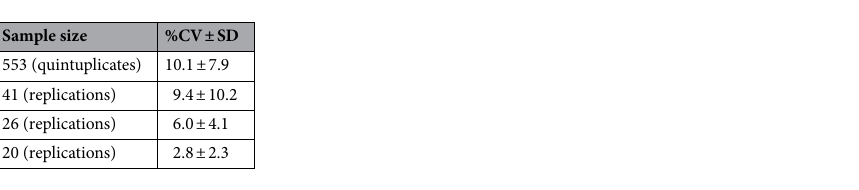
Table 3. Performance statistics of the optimized FXP assay. CV Coefficient of variation, SD Standard deviation.